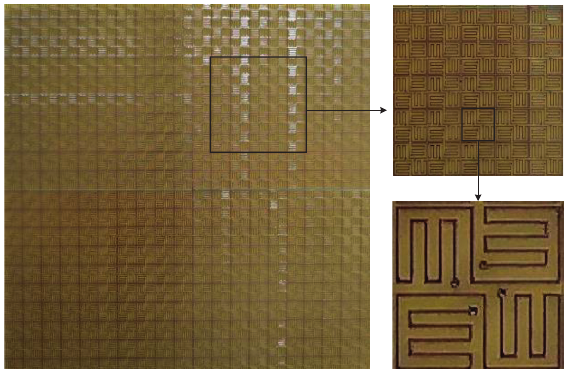
Figure 7: Fabricated prototype of the double-layer FSS.